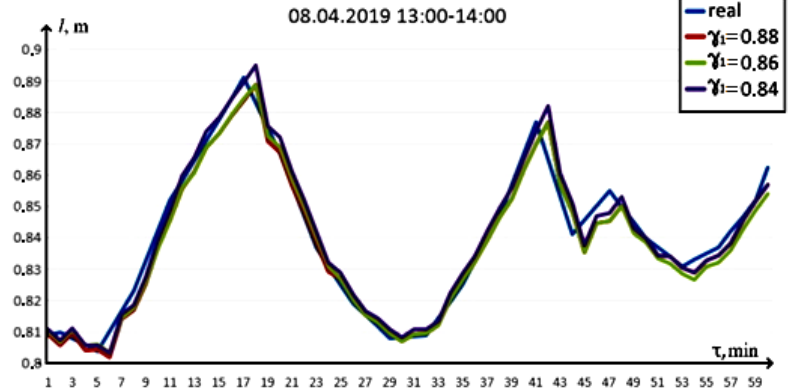
Figure 3. Prediction of the flare length in critical zone, i.e., the active combustion zone, as the main parameters of management quality.